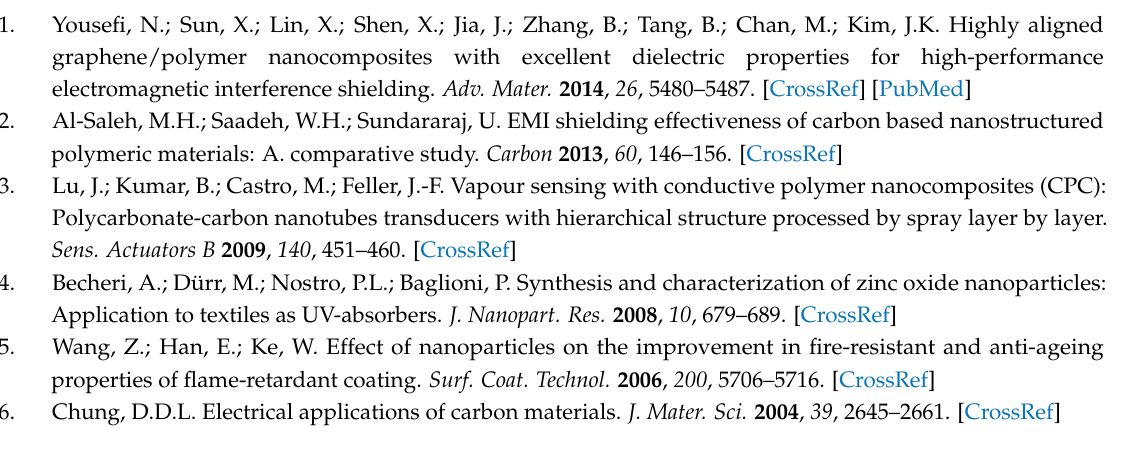
s1, Figure S1: Vibration responses measured under frequencies of 100, 200, 500 and 1000 Hz. The amplitudes of the signals have been adjusted to clearly show the waveforms identified; Figure S2: Vibration responses measured under frequencies of 5, 10 and 20 kHz. The amplitudes of the signals have been adjusted to clearly show the waveforms identified.